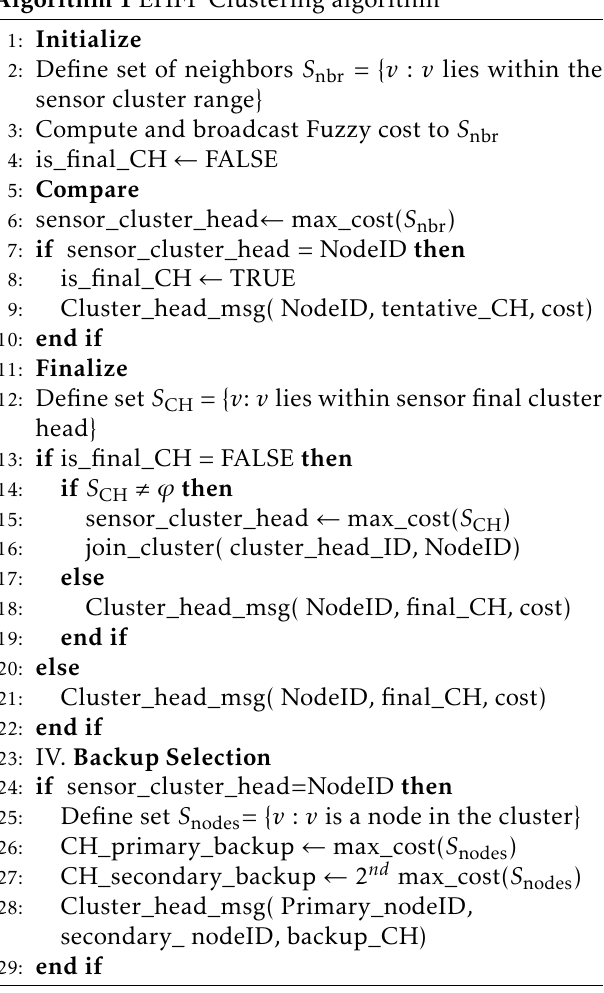
Algorithm 1 EHFP Clustering